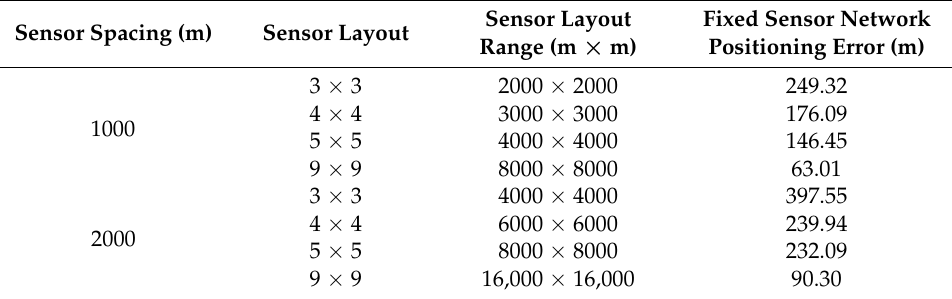
Table 3. Average positioning error of different layouts with the same sensor interval.